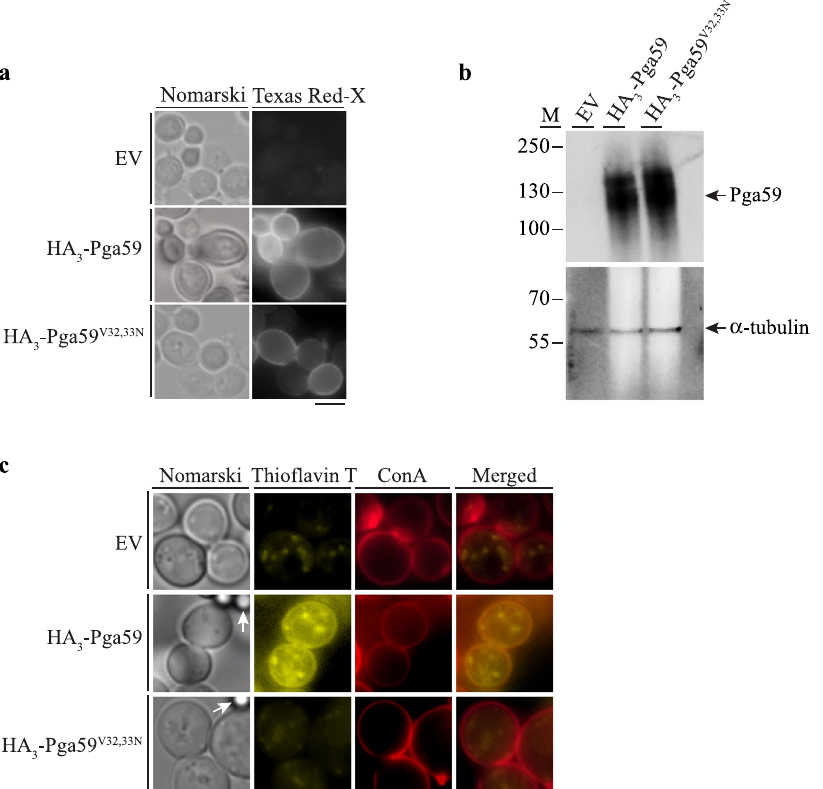
Fig. 3 Heterologous expression of Pga59 in the budding yeast leads to amyloid structures assembly in the cell wall. a S. cerevisiae strains expressing HA 3 -Pga59, HA 3 -Pga59 V32,33N or the empty vector as a negative control (EV), were cultivated in a YPD medium. The cellular location of HA 3 -Pga59 and HA 3 -Pga59 V32,33N upon cell adhesion was assessed by immuno fl uorescence microscopy using an α -HA antibody. Right panels: Fluorescent signals observed with an α -mouse Texas Red-X conjugate as a secondary antibody. Left panels: Nomarski. b Pga59 levels were assessed in each genetic background by western blot ( α -HA antibody, top) using α -tubulin (bottom) as a loading control. The chemiluminescent signals were obtained using a monoclonal α -mouse HRP secondary antibody. Left: Molecular weight standards (M). c amyloid assembly was assessed in the indicated strains by ThT staining (yellow channel) upon adhesion triggered by BSA-coated magnetic beads (arrows in the left panels). The cell wall of S. cerevisiae was stained with the Concanavalin A, Alexa Fluor 594 conjugate (red channel). Yellow and red channels were merged on the right part of the panel. Scale bar: 5 μ m. The data presented here are representative of three independent experiments. Source data are provided as a Source Data fi